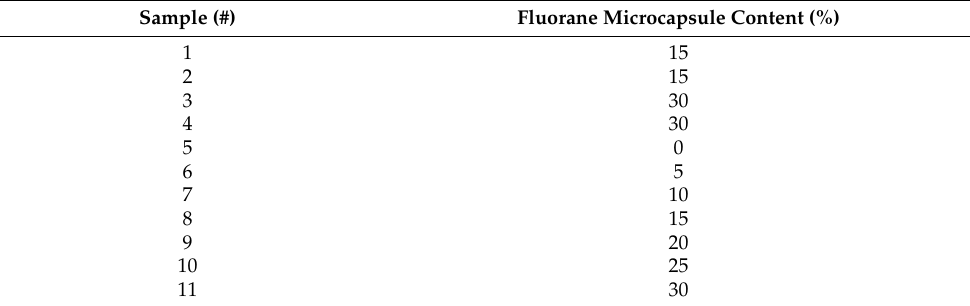
Table 2. The ingredients of waterborne thermochromic